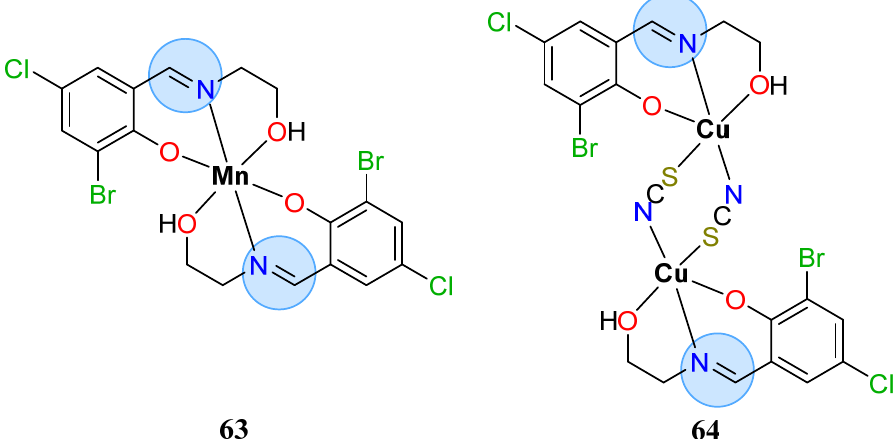
Figure 27. Mn(II) and Ni(II) complexes from tridentate Schiff base ligand (NNO) with antifungal activity.